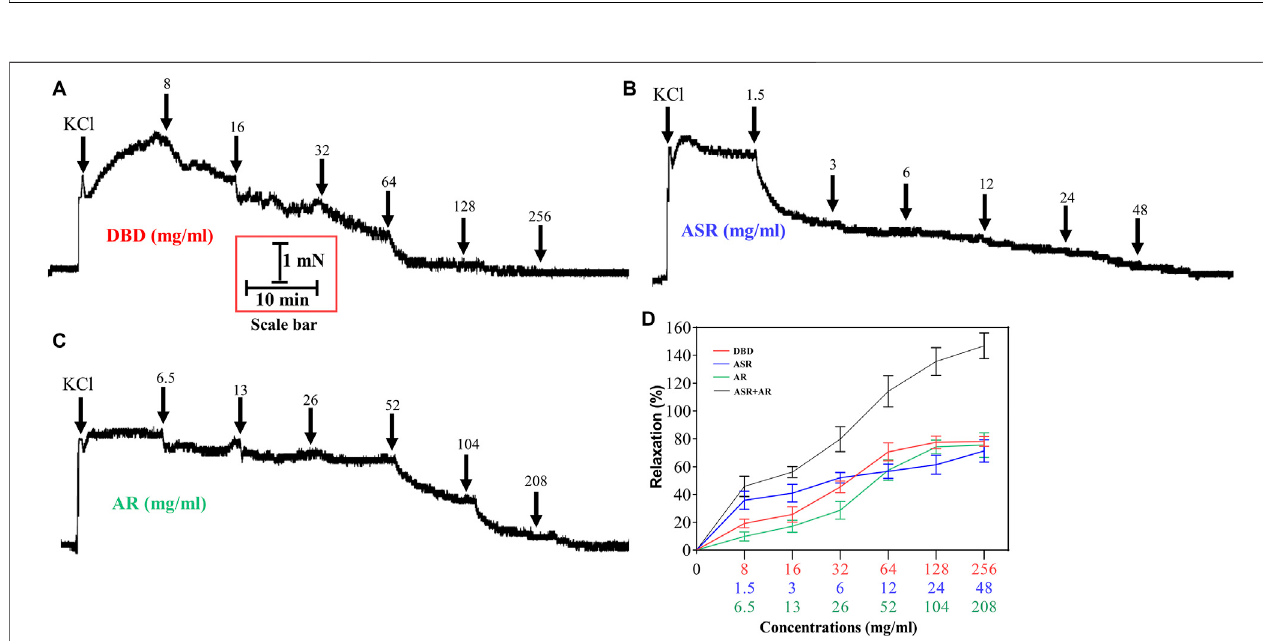
FIGURE 6 | Effect of DBD and its compatibility ratio of ASR and AR monotherapy on the regulation of 60 mM KCl precontracted vascular tension. Diagrams of the effect of cumulative addition of DBD (A) , ASR (B) , and AR (C) on KCl preconstricted MCA of rats. Data were expressed as the mean ± S.E.M. (n (cid:2) 5). DBD, Danggui Buxue decoction. ASR, Angelicae Sinensis Radix. AR, Astragali Radix. MCA, middle cerebral artery.